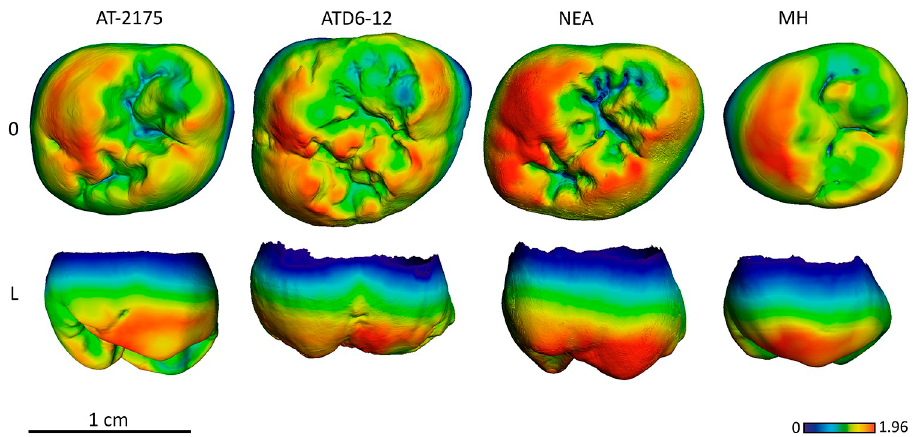
Fig 10. Enamel thickness cartographies of the Atapuerca-SH upper M2 (AT-2175) compared with those of H . antecessor (ATD6-12) from Atapuerca-Gran Dolina, Neanderthal and modern human. Topographic thickness variation is rendered by a pseudo-color scale ranging from thinner dark-blue to thicker red. NEA = Neanderthal (Krapina D96) and MH = modern human of European origin (O = occlusal, L = lingual). Scale bar = 1.96 for all specimens. (When needed specimens have been mirrored to the left to match the SH specimen).